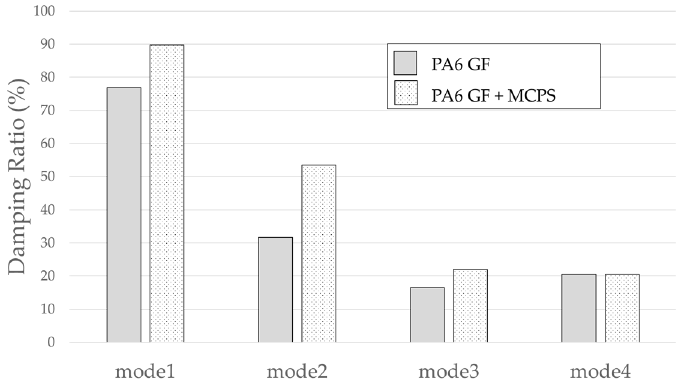
Figure 12. Effects of MCPs on damping ratio of plate specimen.